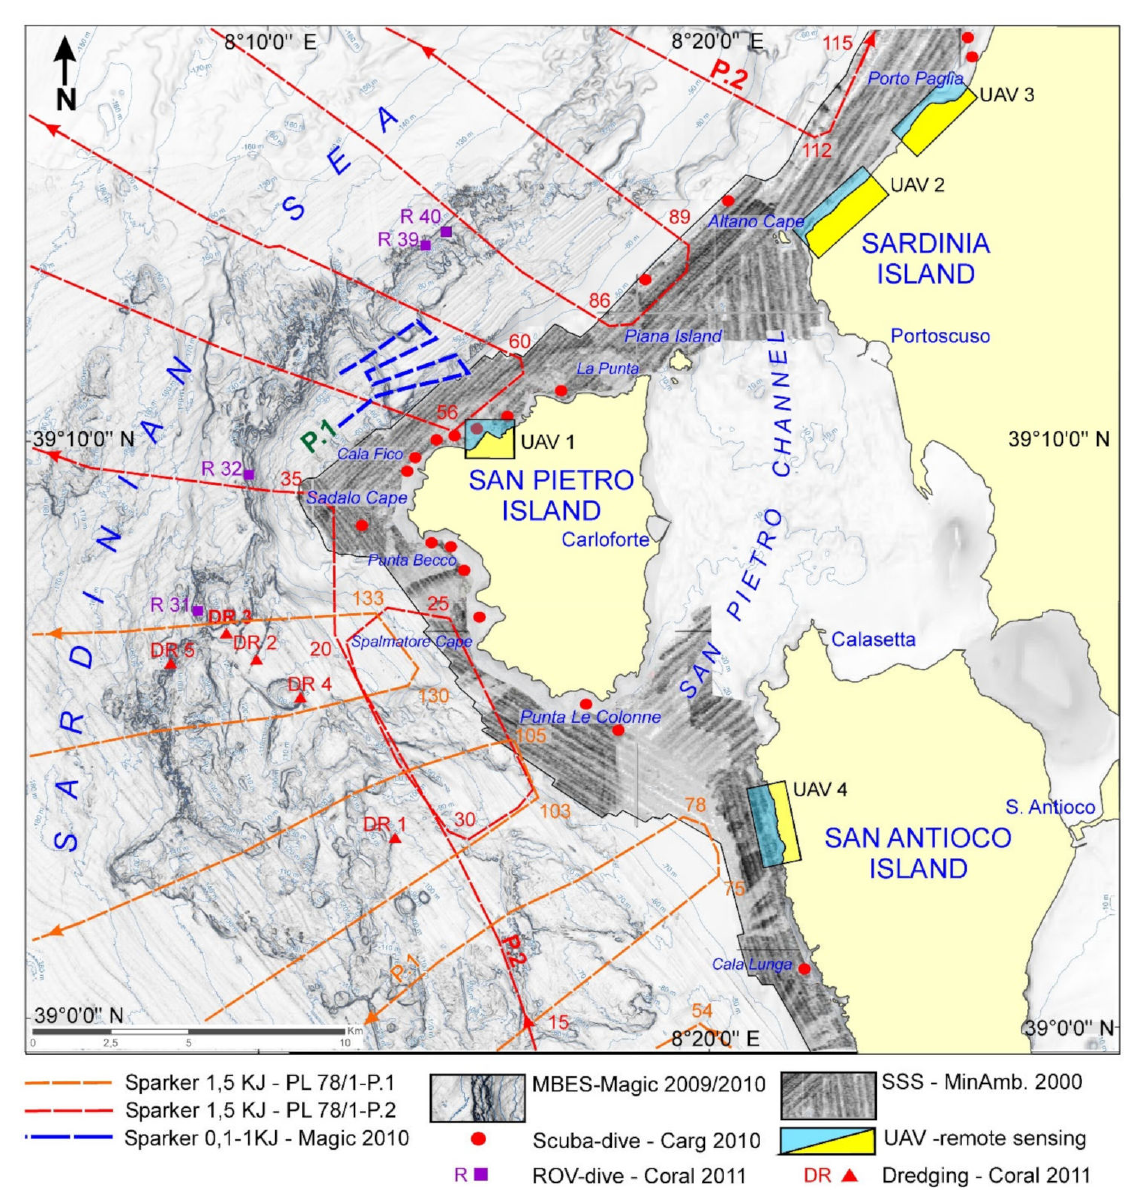
Figure 5. Data locations: spatial coverage multi-beam echosounder (MBES), side scan sonar (SSS) and uncrewed aerial vehicle (UAV); seismic profiles, scuba-dive and ROV stations; dredging sampling